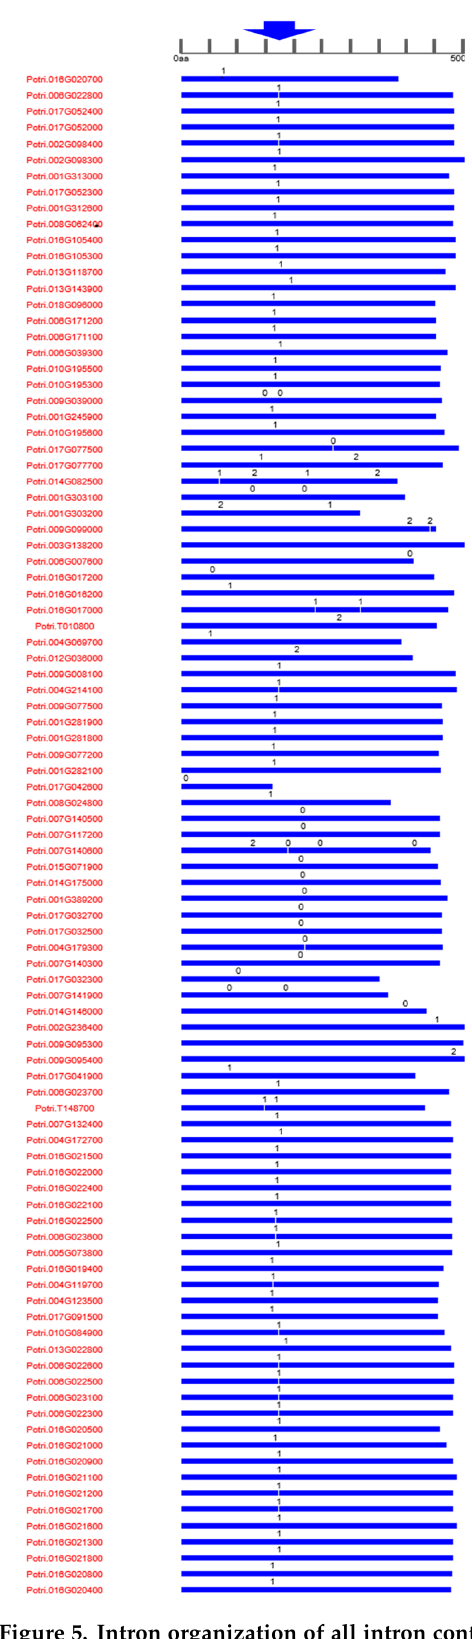
Figure 5. Intron organization of all intron containing UDP glycosyltransferases (UGTs) in Popu- lus . Introns between 150–200 amino acids were found maximally conserved regarding their insertion and phase.